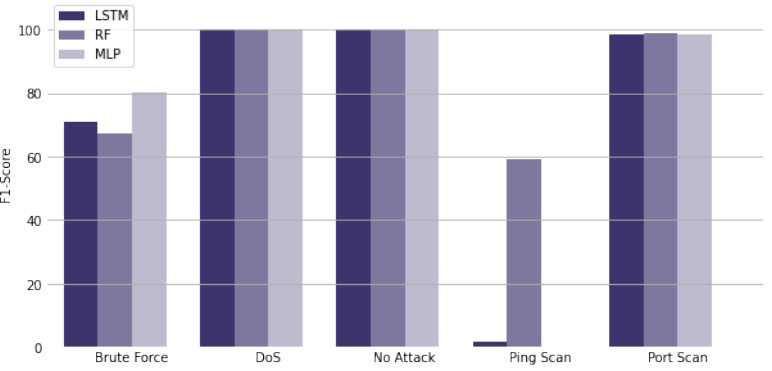
Figure 8. Single-Flow f1-score values of the LSTM, RF and MLP models for the Brute Force, DoS, No Attack, Ping Scan and Port Scan